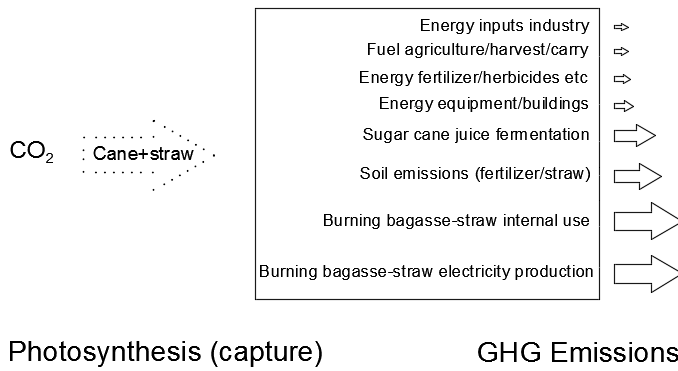
Figure 2. Capture and CO 2-equivalent emissions in the sucroenergy sector (arrows represent proportionality values).